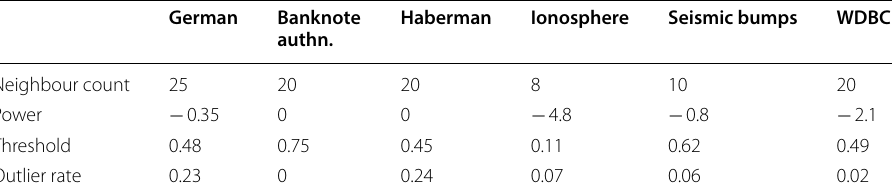
Table 1 Filtering parameters for each dataset German Banknote